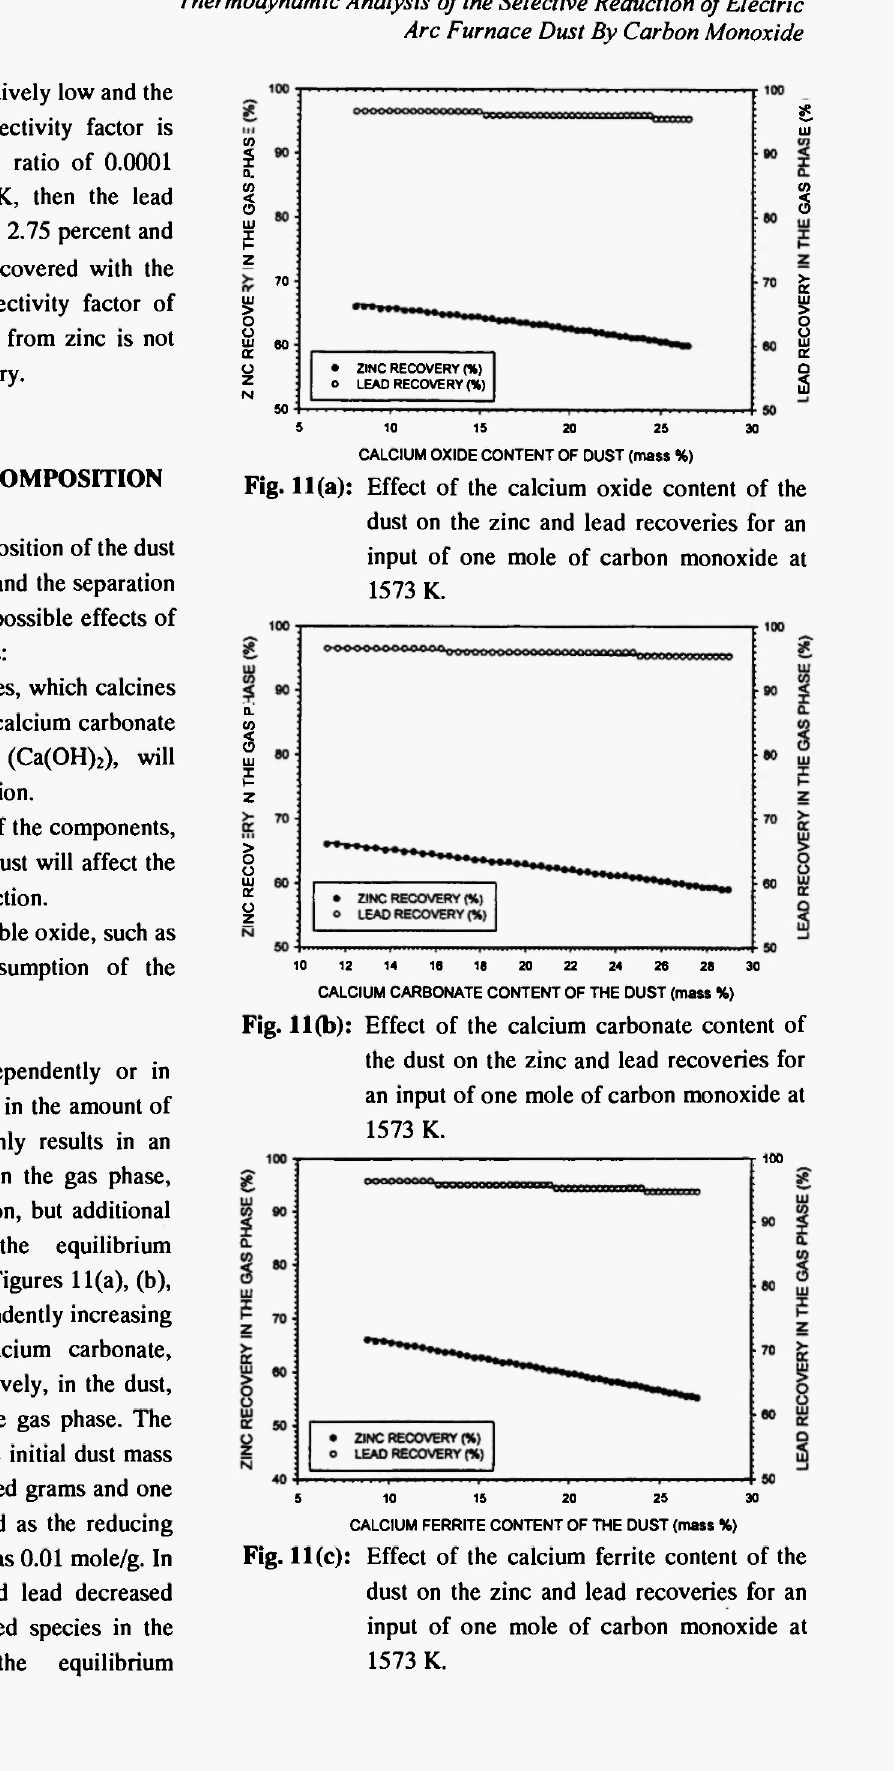
CALCIUM FERRITE CONTENT OF THE DUST (mass %) Fig. 11(c): Effect of the calcium ferrite content of the dust on the zinc and lead recoveries for an input of one mole of carbon monoxide at 1573